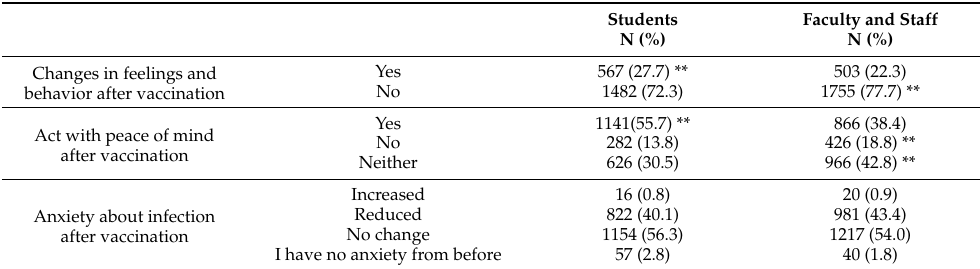
Table 3. Comparison of students and faculty and staff.